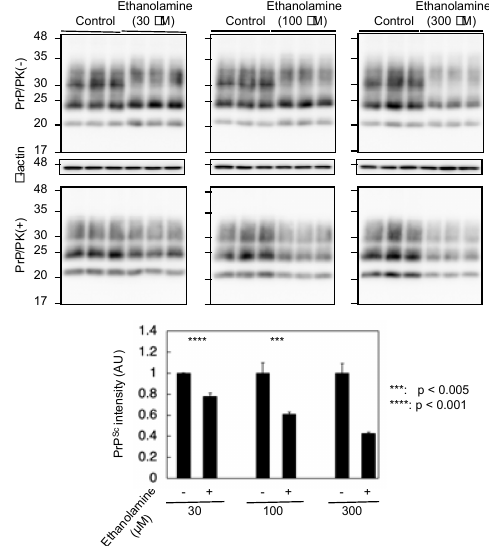
Figure 4. The anti-prion activity of ethanolamine is dose-dependent. Western blotting with 6D11 anti-PrP antibody of cell lysates from N2aC24L1-3 cells cultured in classic DMEM supplemented with 30 µ M (1.83 mg/L), 100 µ M (6.11 mg/L), and 300 µ M (18.3 mg/L) of ethanolamine for 6 days. The densities of the PK-resistant fragments of PrP Sc were statistically analyzed.